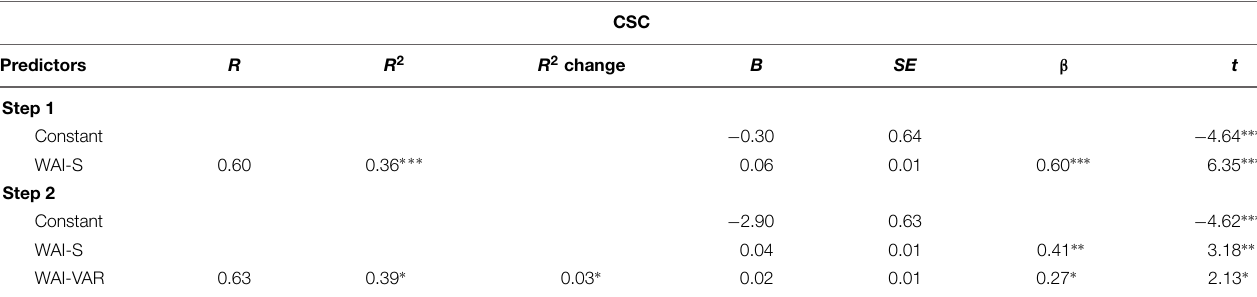
TABLE 3 | Multiple regression of